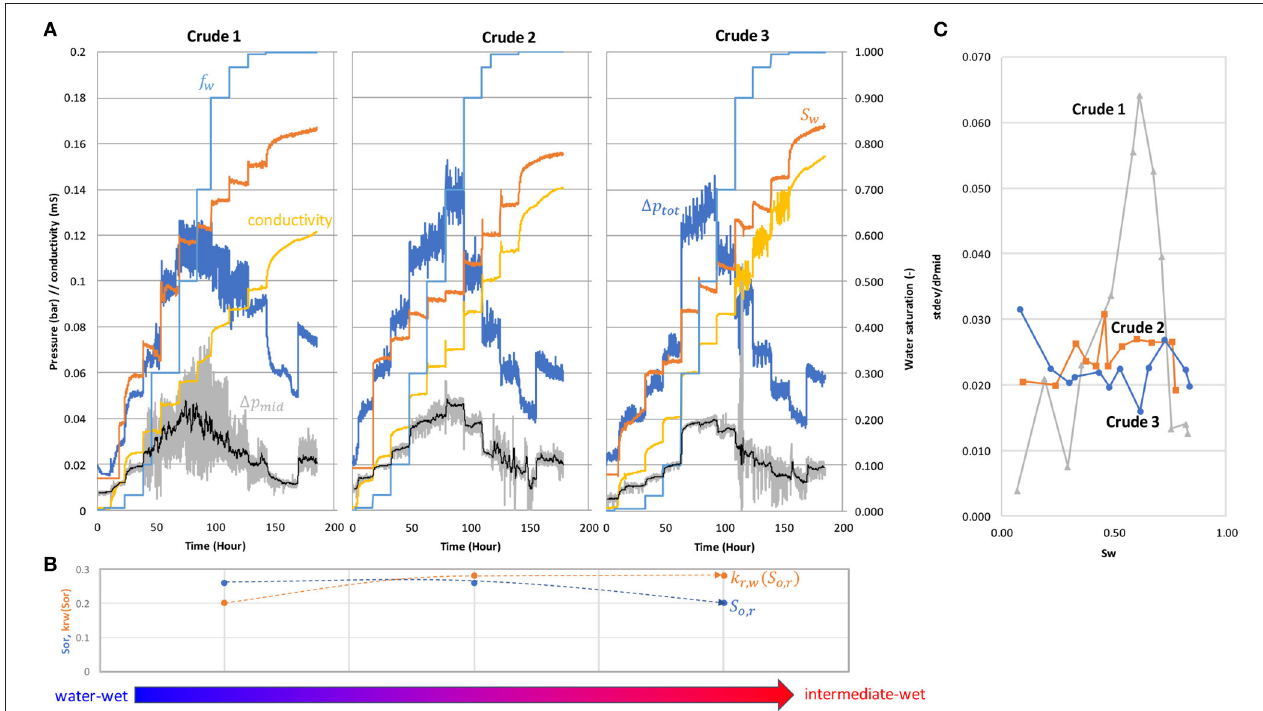
FIGURE 9 | Dependency of the fluctuations on the wetting state of the rock. Pressure fluctuations are largest for the Bentheimer rock sample aged with crude 1 and become much smaller for Bentheimer samples aged with crude 2 and 3 (A) . The trends for residual oil saturation S o , r and water endpoint relative permeability k r , w ( S o , r ) suggest that the wettability for the sample aged with crude 1 is more water-wet, whereas samples aged with crude 2 and crude 3 become increasingly intermediate-wet (B) . The standard deviation of the pressure fluctuations normalized by the mean pressure for each fractional flow f w is largest for crude 1 (which is the most water-wet case) and becomes significantly less for crude 2 and 3 (C)